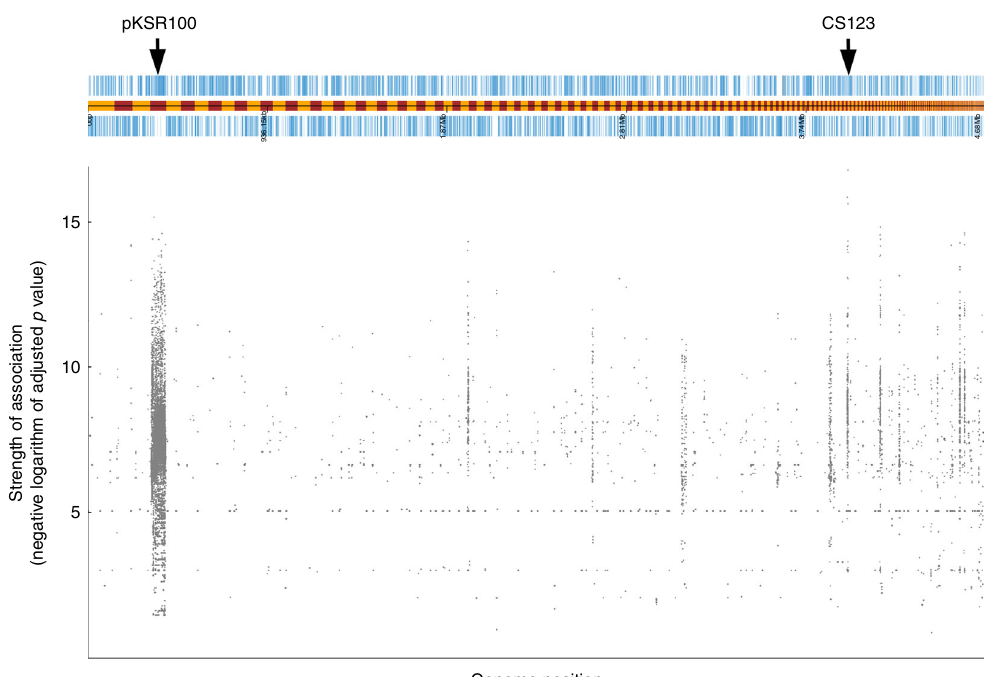
Fig. 3 Genome-wide association analysis of MSMA sublineages. The draft genome of a S. fl exneri 2a isolate (ERR1364107) is shown above, with the coding frames on forward and reverse strands of the genome appearing upper and lower to the intervening track (yellow and maroon banded), which shows the boundary of contiguous sequences. The pKSR100 contiguous sequence as well as contiguous sequence 123 (which contains sequence elements of marginally higher signi fi cance than pKSR100) are labelled. The Manhattan plot under the genome assembly shows the mapping position of sequence elements with a signi fi cant positive-association to MSMA sublineage designation, with the vertical scale representing the negative logarithm of the adjusted p value (i.e., the signi fi cance) of the